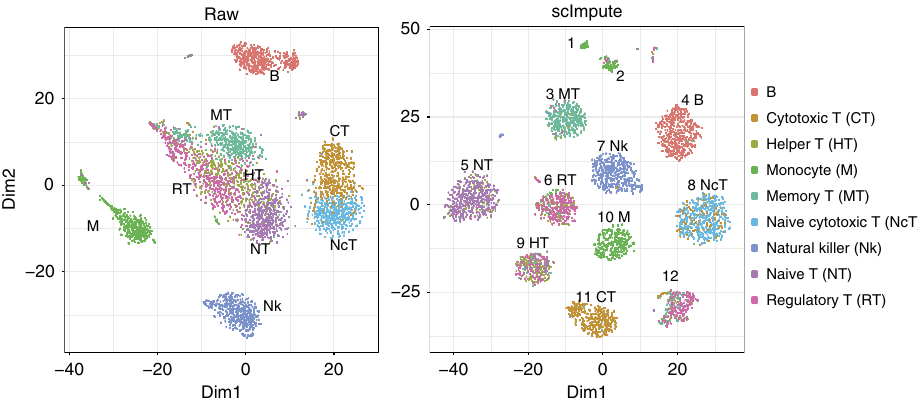
Fig. 6 scImpute helps identify cell subpopulations in the PBMC dataset. The scatter plots give the fi rst two dimensions of the t-SNE results calculated from raw and imputed PBMC dataset. Numbers marked on the imputed data are cluster labels. Cell type information is marked for major clusters. We note that for the raw data, we did not mask zero expression values as missing values in the dimension reduction and the clustering